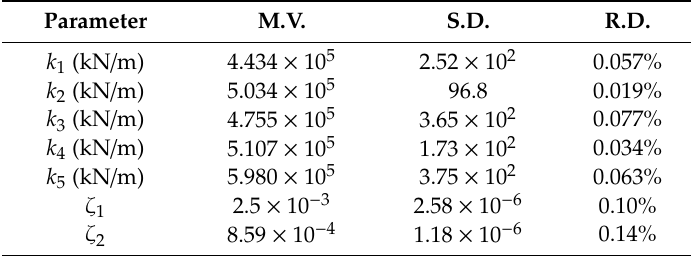
Figure 12. Marginal posterior probability distributions of the six estimation parameters ( k 1 , k 2 , k 3 , k 4 , k 5 , ζ 1 ). Table 7. Summarizing statistics of the posterior parameter distribution mean value (M.V., standard deviation (S.D.), and relative deviation (R.E.)).